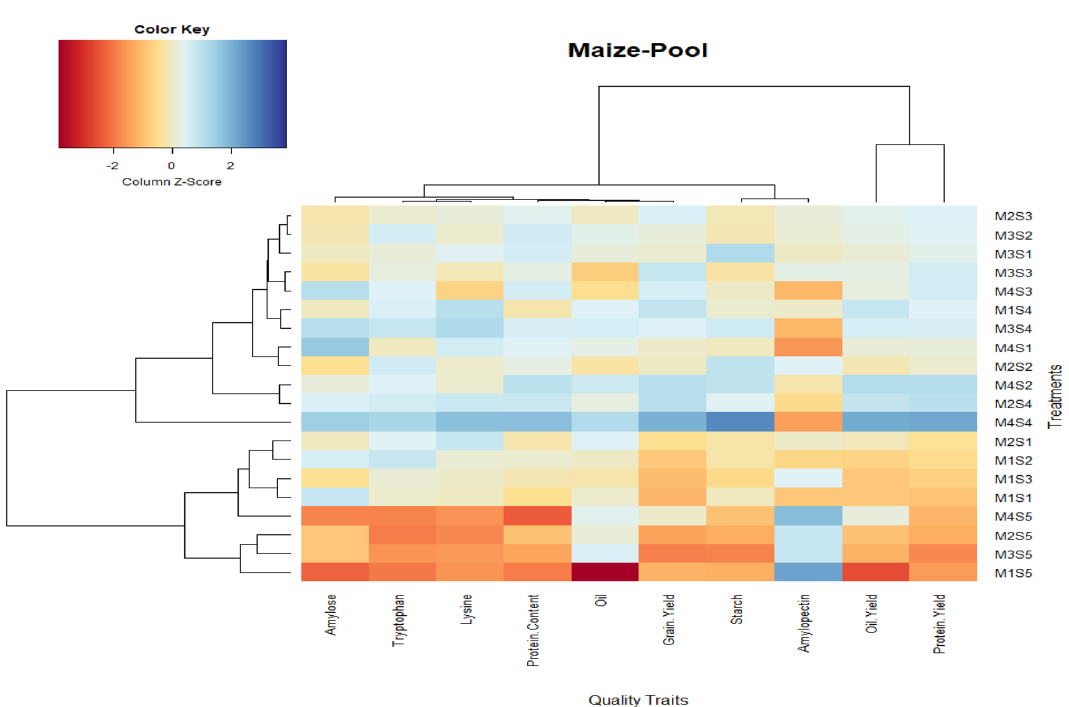
Figure 9. Biclustering heatmap analysis of maize productivity and the quality parameters at different treatment combinations of CETMs and PFPs in maize (pooled data), using R-software package ‘gplots’, Software version number ‘R package version 3.1.1’, Software URL https:// CRAN.R- proje ct. org/ packa ge=